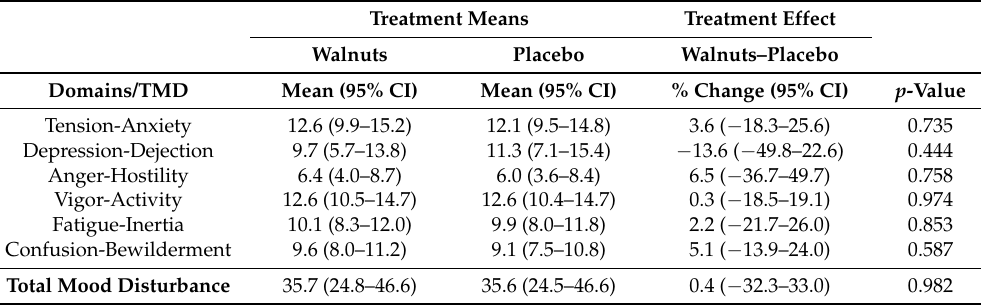
Table 6. Mean scores and changes in POMS for females on walnut and placebo diet ( n =